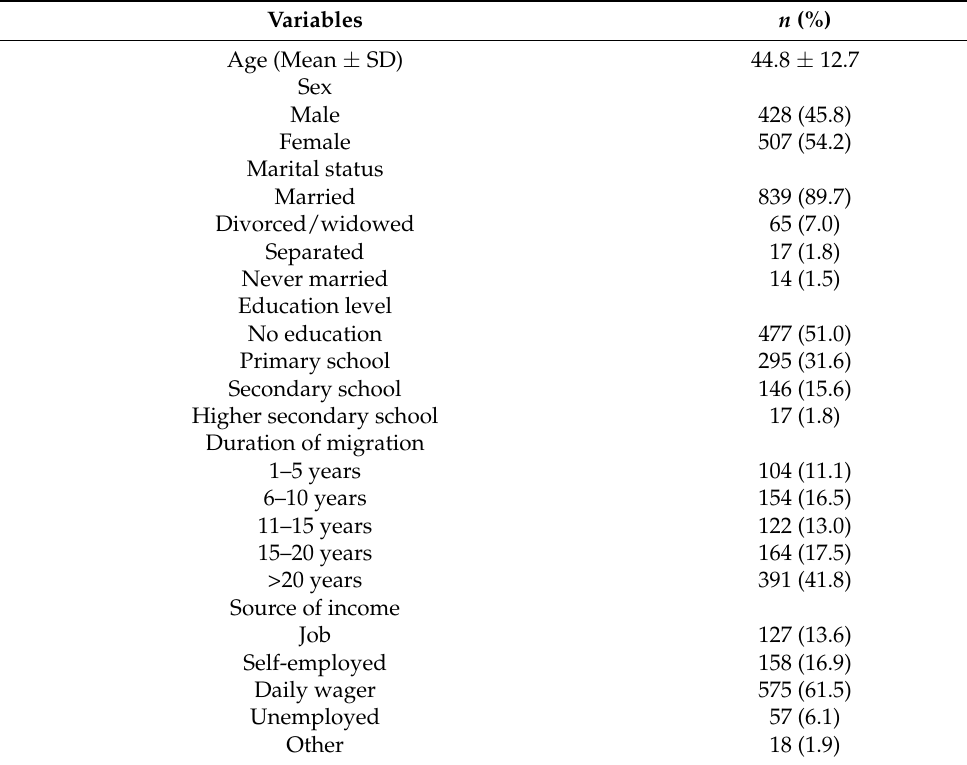
Table 1. Distribution of all categorical variables ( n =